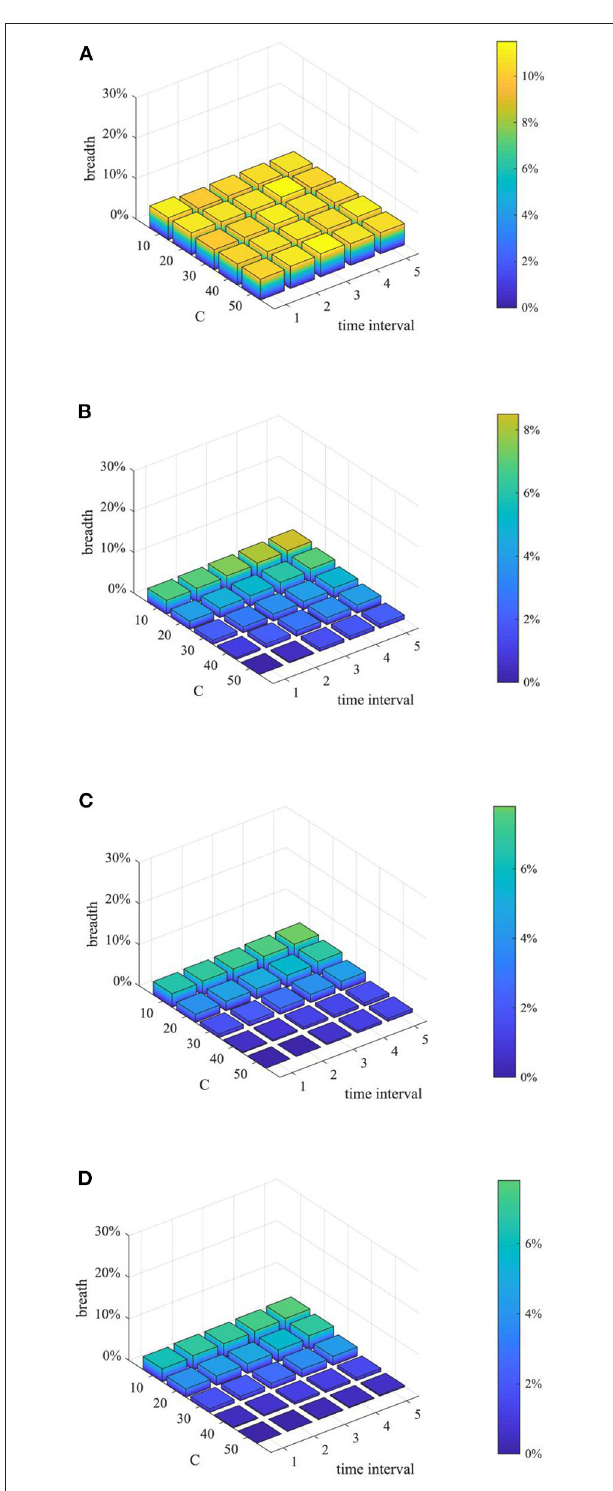
FIGURE 18 | Rumor diffusion range based on different combination. (A) t = 10. (B) t = 20. (C) t = 30. (D) t = 40.